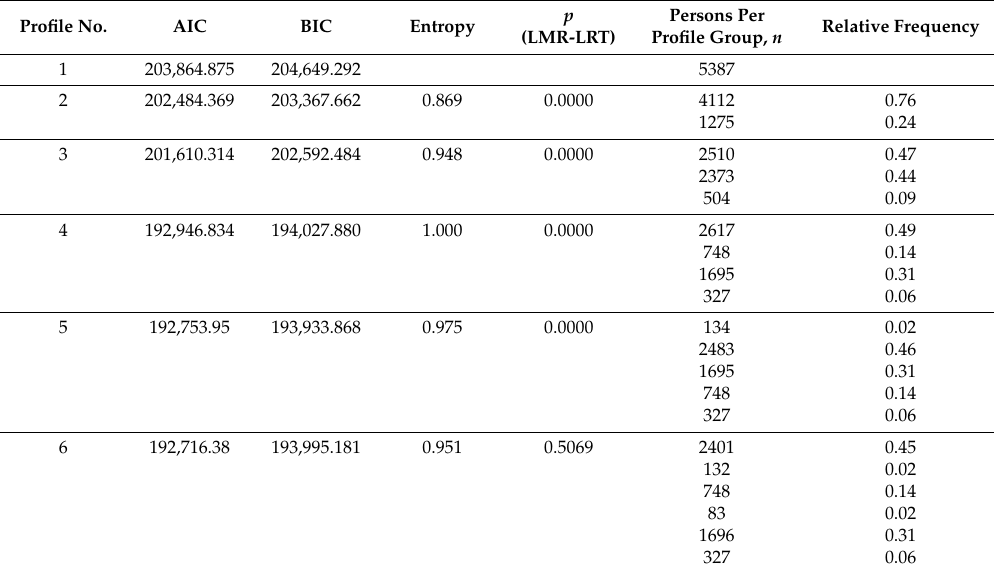
Table 2. Fit indices of the